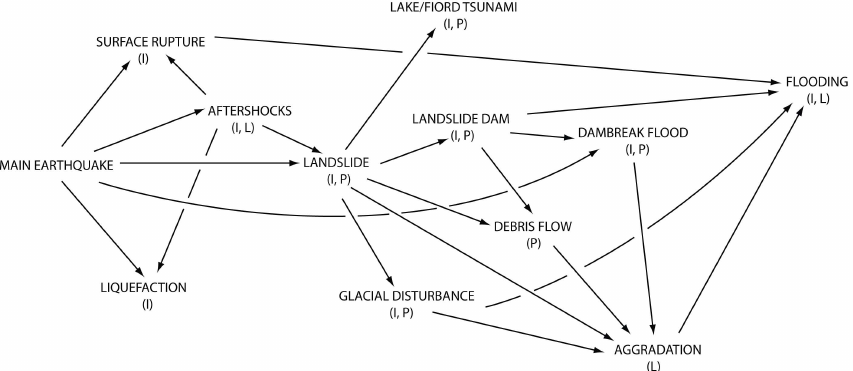
Fig. 4. Flow chart of geomorphic consequences resulting from an earthquake. I – immediate: occurring seconds to days after the event; P–prolonged: lasting weeks to years; L – long-term: lasting years to